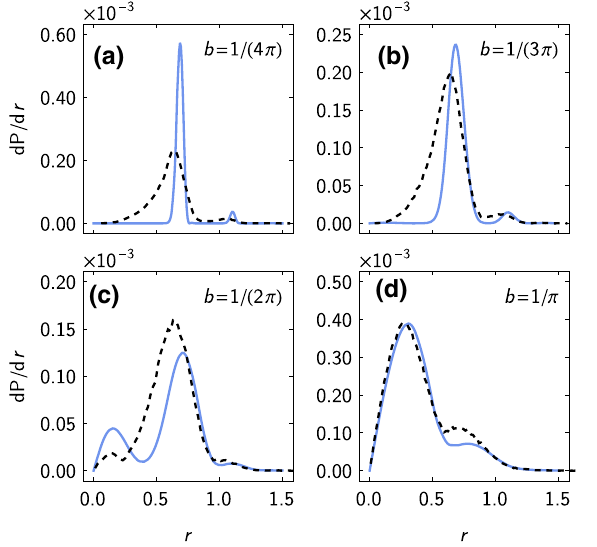
Fig. 9 Perpendicular momentum spectra d P / d r for a photon with energy parameter η = 1 . 5 colliding with a plane-wave, CP laser pulse of peak amplitude ξ = 0 . 2, N = 16 and chirp parameter b : results from QED (blue, solid) and from LMA-based simulations (black, dashed)